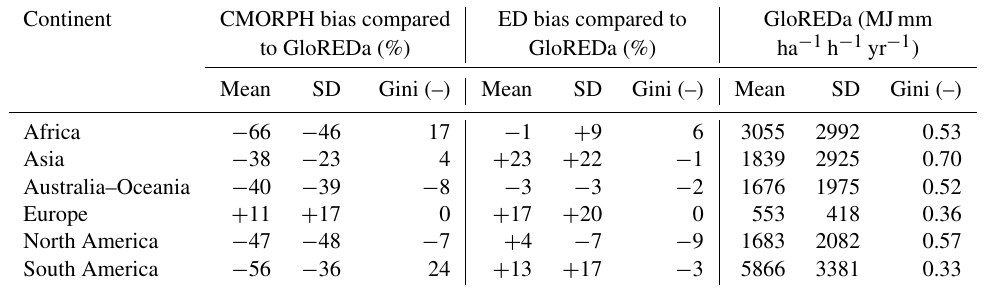
Table 3. A comparison between CMORPH-, ED-concept-, and GloREDa-derived global rainfall erosivity at a continental scale.